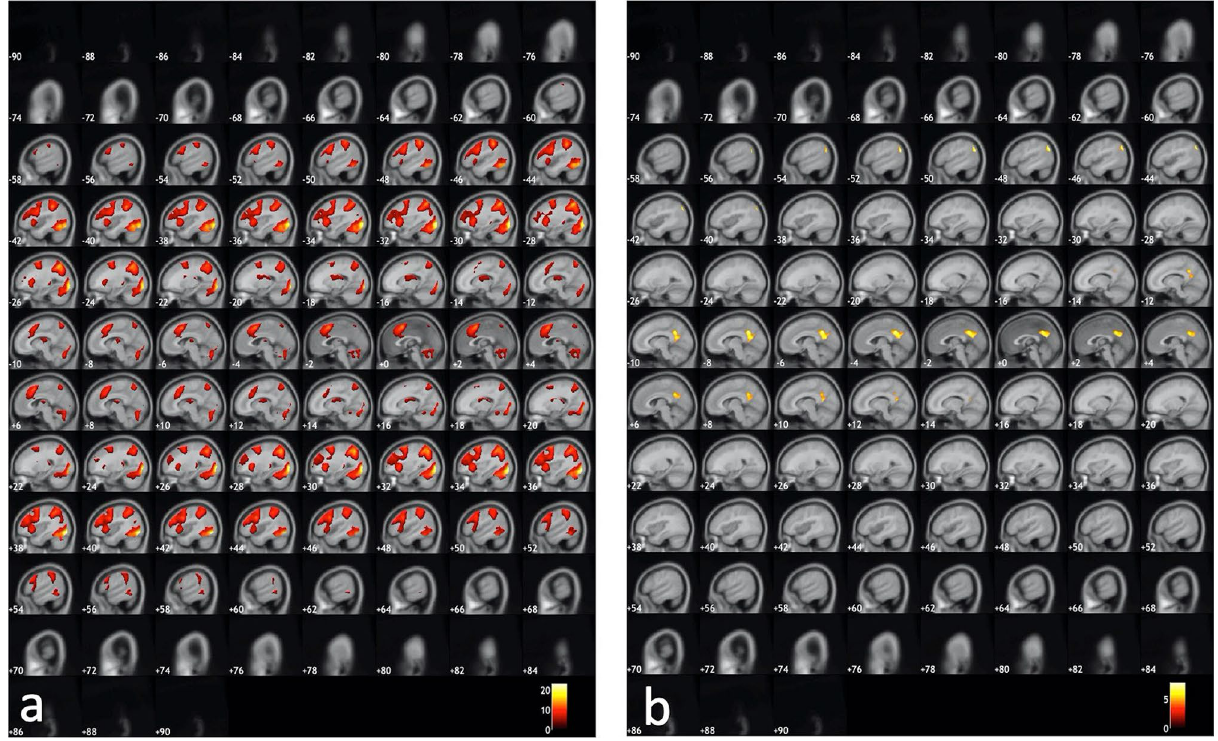
Figure 1. Activations that passed the .05 FWE-corrected significance threshold, shown on sagittal slices of the MNI-template. The panel ( a ) to the left shows activations obtained during ON-blocks contrasted with activations obtained during OFF-blocks (ON–OFF). The panel ( b ) to the right shows activations obtained with the contrast flipped, i.e. obtained during OFF-blocks contrasted with activations obtained during ON-blocks (OFF–ON). See “Results” for further in the left-hand panel and corresponding activations for the OFF–ON contrast seen in the right-hand panel. A cluster size of minimum 20 voxels was used and slices are shown with 2 mm spacing. The ON–OFF contrast produced significant, p = 0.05, FWE-corrected activations in the right SMA (MNI coordinates: × 4, y 14, z 50), right inferior occipital gyrus (× 32, y − 85, z − 32), right angular gyrus (× 30, y − 64, z 44), left superior parietal lobule (x − 26, y − 58, z 54), right and left precentral gyrus (× 46, y 10, z 32, and x − 46, y 4, z 30, respectively), left anterior insula (x − 30, y 18, z 6) and left middle frontal gyrus (x − 26, y − 4, z 50). All t-values were > 7.46, critical 0.05 t-value was = 4.40 with 447 df. The OFF–ON contrast produced cor- responding activations in the left precuneus/posterior cingulate gyrus (PCC) (x − 6, y − 54, z 32/ × 0, y 52, z 31), left and right angular gyrus (x − 48, y − 70, z 36 and × 50, y − 68, z 30) and in the right central operculum (× 38, y − 14, z 18). All t-values were > 4.97 with a critical 0.06 t-value = 4.40. Figure 2 shows the results split for the three tasks, with activations overlaid on the MRICron anatomical template (ch2.better.niftii) as different layers and colours: As seen in Fig. 2, the main findings from the overall conjunction analysis were confirmed in the separate analyses, with essentially similar patterns of activations for all three tasks. Activation caused by the working memory task is shown in red in Fig. 2, activation caused by the mental rotation task is shown in blue and activations caused by the mental arithmetic task is shown in green. Common activations across all three tasks are correspondingly indicated in white colour. Common activations for the mental rotation and working memory tasks are indicated in violet colour. Common activations for the mental rotation and mental arithmetic tasks are indicated in cyan colour, and common activations for the working memory and mental arithmetic tasks are indicated in yellow colour. Analysing the contrasts separately for each task also yielded activations beyond what was seen in the conjunc- tion analysis across tasks. For the ON–OFF contrast, the mental rotation task yielded additional activation in the right thalamus (× 24, y − 30, z 4), and the mental arithmetic yielded additional activations in right and left thalamus (× 26, y − 30, z 2, and x − 24, y -30, z 0, respectively). For the OFF–ON contrast, the corresponding additional activations for the working memory task were seen in the left and right lingual gyrus (x − 24, y − 44, z − 8 and × 30, y − 38, z − 12, respectively), in the left medial and lateral superior frontal gyrus (x − 2, y 58, z 8 and x − 16, y 38, z 52, respectively) and in the right posterior insula (× 38, y − 12, z 16). For the mental arithmetic task, the corresponding additional activations were seen in the right cerebellum (× 30, y − 74, z − 40), left middle temporal gyrus (x − 62, y 34, z 48) and in the left superior frontal gyrus (x − 22, y 34, z 48). We then identified overlapping activations for all three tasks in the SMA and precuneus/PCC and defined them as new ROIs for the subsequent analysis, as these regions are key nodes in the EMN and DMN networks, respectively 2,17 . The ROIs are shown on top of the anatomy template in the upper panel of Fig. 3a,b. The mean